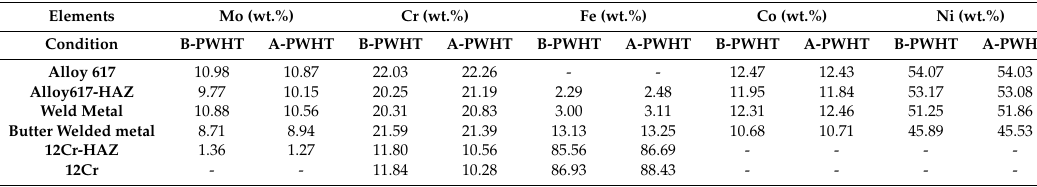
Figure 3. Optical micrographs of important regions after PWHT: ( a ) Alloy 617, ( b ) Alloy617-HAZ, ( c ) Weld metal, ( d ) 12Cr-HAZ and ( e ) 12 Cr.